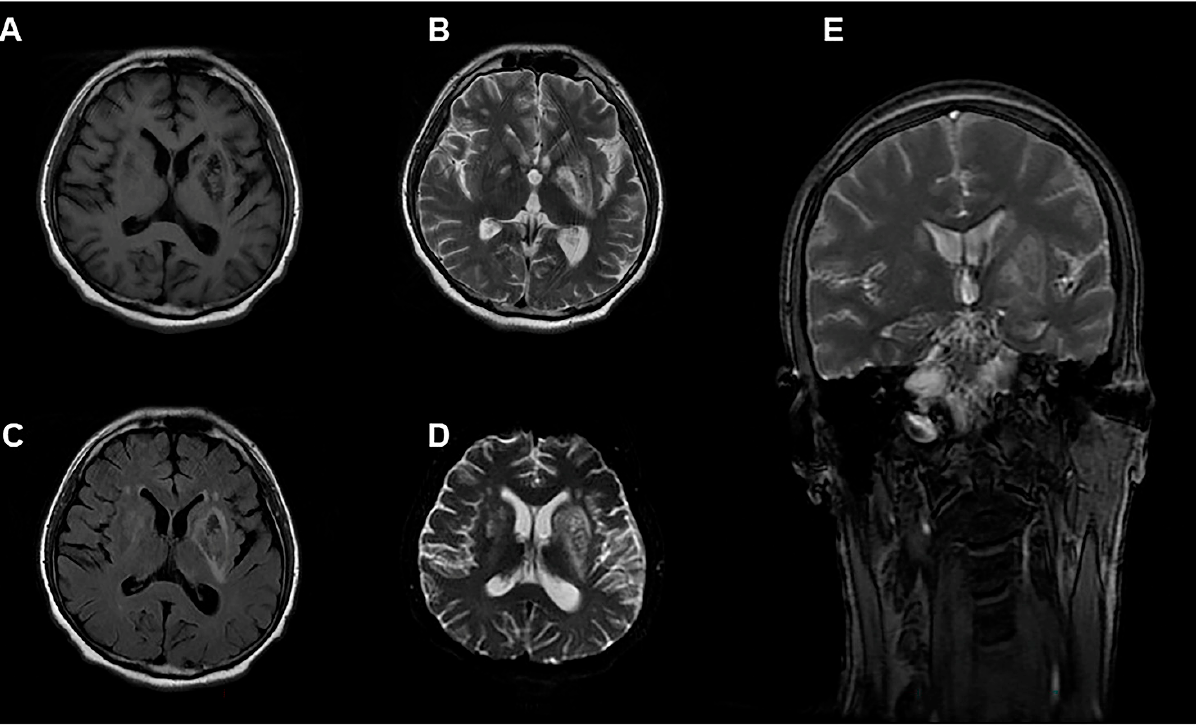
Figure 2. Images of a 35-year-old man exposed to 5-amino-2-(trifluoromethyl)pyridine. MRI 20 days after exposure showing abnormal signal intensity on ( A ) T1WI, ( B ) T2WI, ( C ) T2 FLAIR, ( D ) DWI and ( E ) T2WI of coronal in the bilateral cerebral hemispheres. T1WI, T1-weighted image; T2WI, T2-weighted image; DWI, diffusion-weighted imaging; FLAIR, fluid-attenuated inversion-recovery sequency.